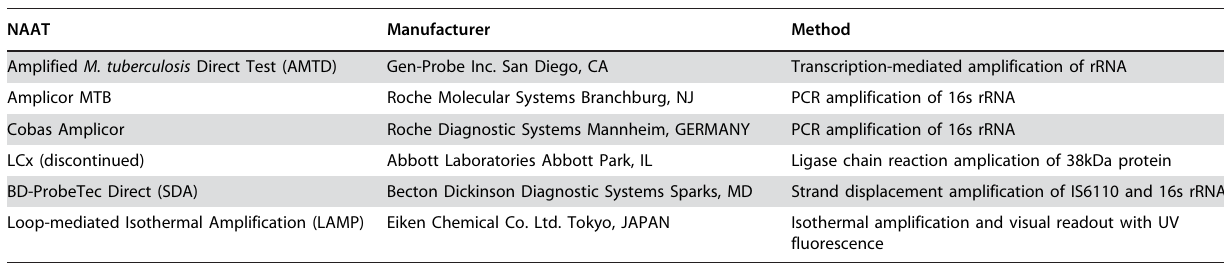
Table 1. Summary of Commercial Nucleic-Acid Amplification Tests (NAAT) for TB .. ... .... ... ... .... ... ... .... ... ... .... ... ... .... ... ... .... ... ... .... ... ... .... ... ... .... ... ... .... ... ... .... ... ... .... ... ... .... ... ... .... ... ...